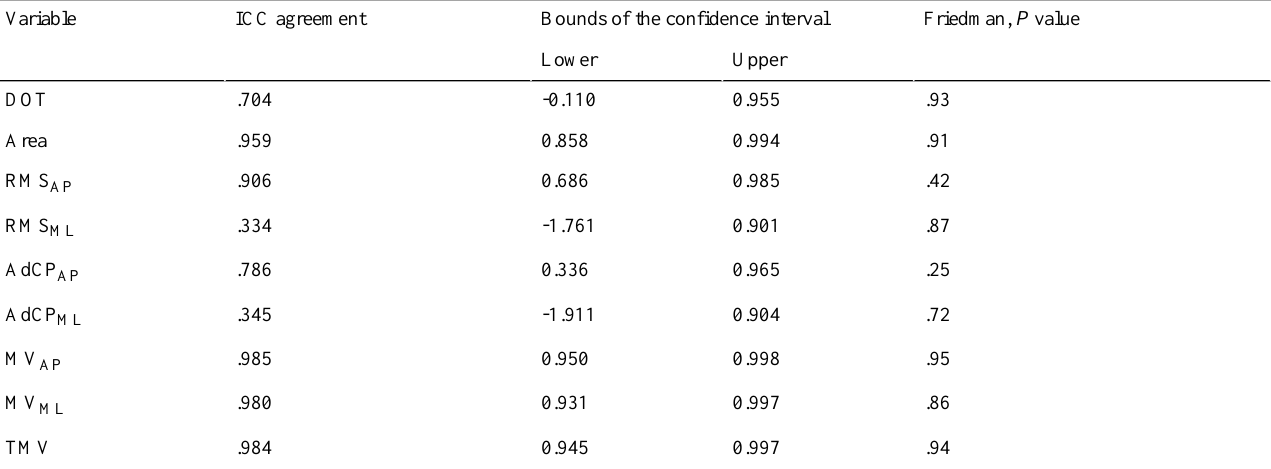
Table 1. Intraclass correlation coefficient (ICC) of the studied parameters for the 4 different devices.